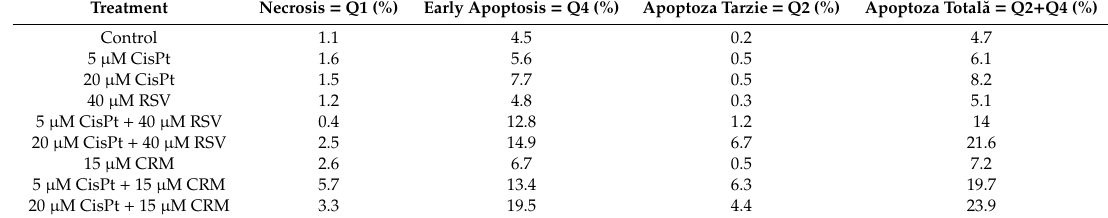
Table 7. Apoptosis of HUVEC cells induced by 24 h treatment with CisPt and / or RSV, CRM.